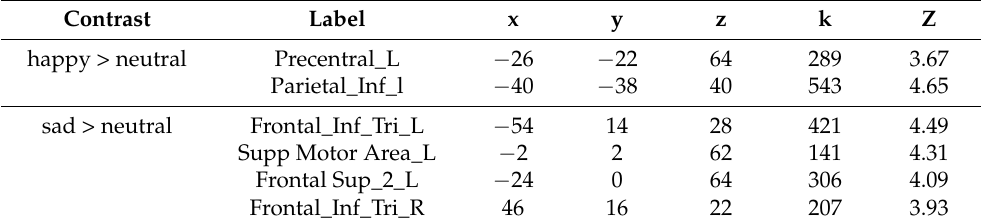
Table 1. Significant clusters for contrasts in the emotion